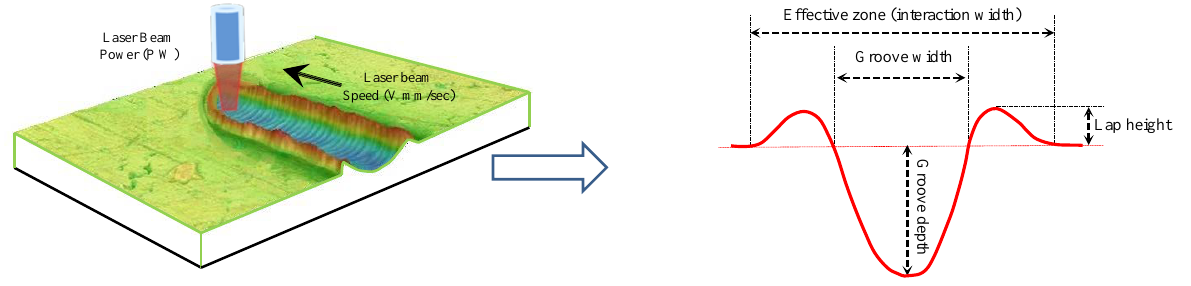
Fig. 1. Laser process and the grove